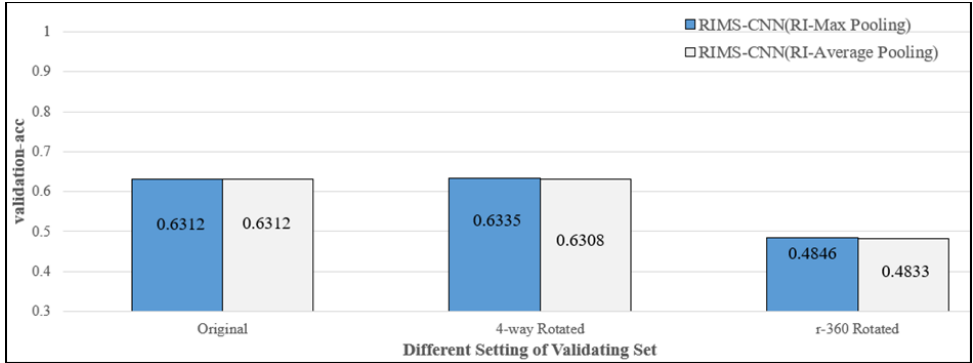
Figure 22. Comparing RI-max pooling with RI-average pooling in the different CIFAR-10 settings.